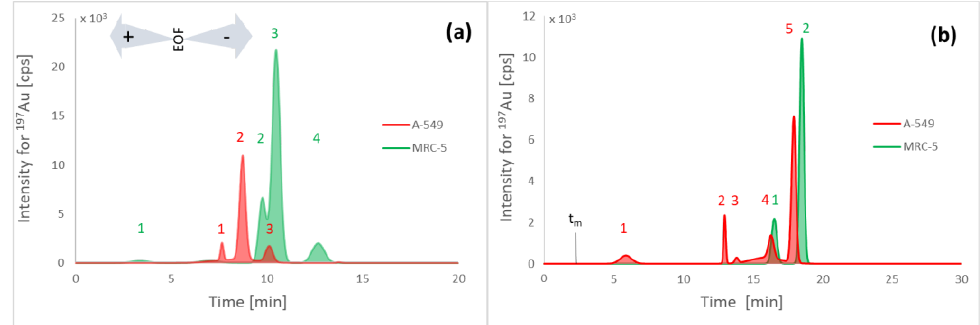
Figure 4. Au-tagged tryptic peptide maps obtained by CZE-ICP-MS ( a ) and µRPLC-ICP-MS ( b ). Electropherograms and chromatograms for the control sample are not shown because only the baseline was observed.